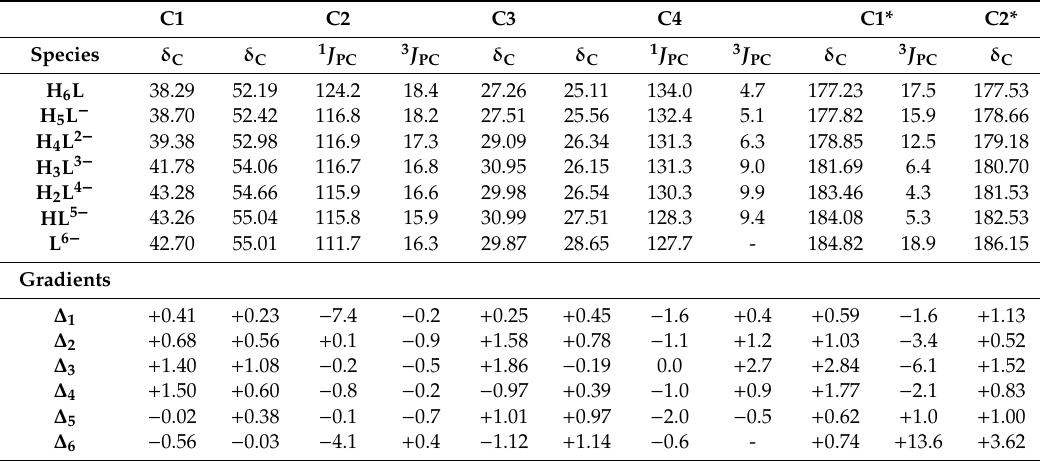
Table 16. Specific chemical shifts δ C [ppm], coupling constants n J PC [Hz] and gradients Δ i [ppm] of